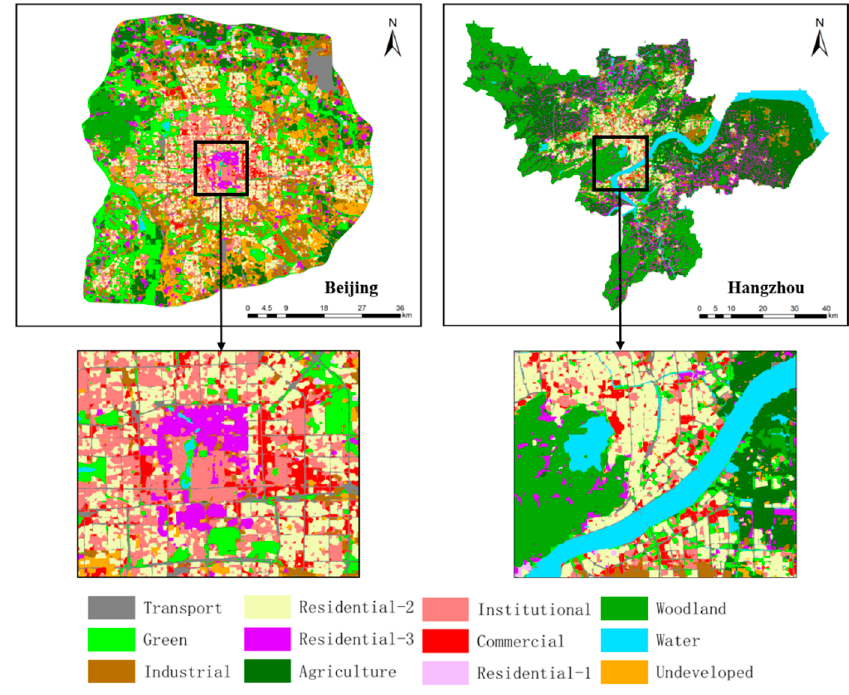
Figure 3. PKU Urbanscape Essential Dataset for Beijing and Hangzhou. Table 2. PKU Urbanscape Essential Dataset class and